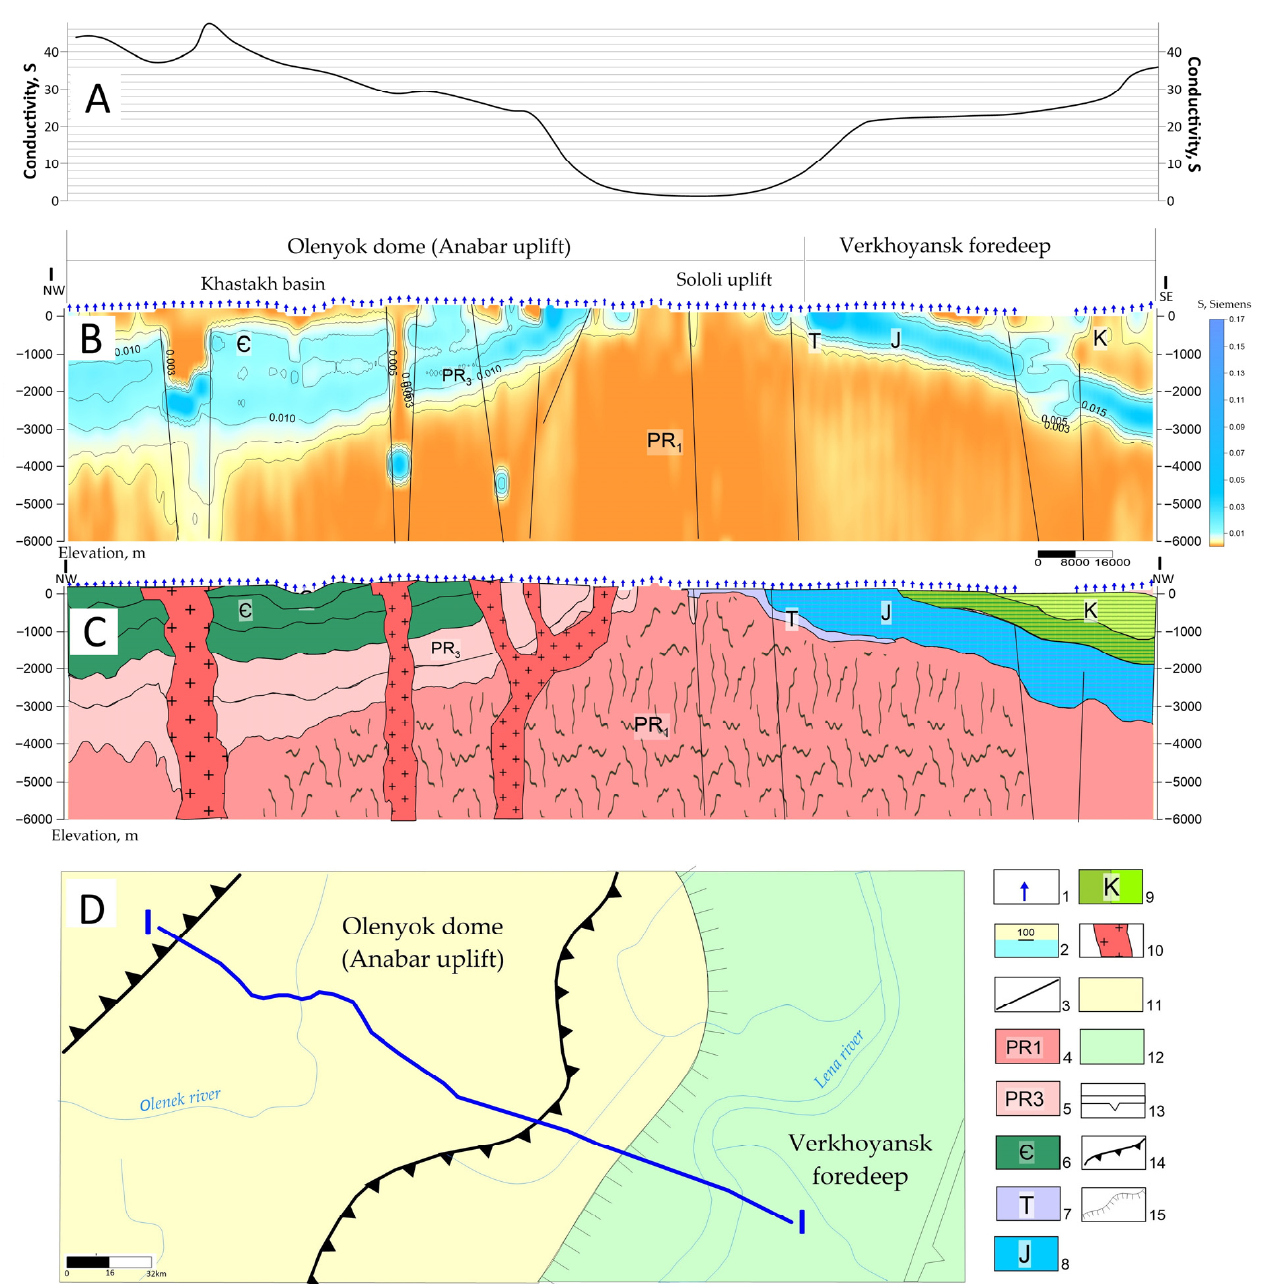
Figure 2. Total conductivity pattern from 2D TEM ( A ); differential conductivity ( B ) and geological ( C ) cross sections imaging the junction between the Olenyok Arch and the Verkhoyansk Foredeep, according to 2D TEM data; simplified local tectonics ( D ). 1 = TEM stations; 2 = resistivity layers and their resistivity in Ohm ‧ m; 3 = inferred faults; 4 = early Proterozoic metamorphic rocks; 5 = Upper Proterozoic clastic and carbonate rocks; 6 = Cambrian carbonate sediments; 7–9 = Triassic (7), Jurassic (8), and Cretaceous (9) clastic sediments; 10 = Early Proterozoic intrusions; 11 = Siberian Craton; 12 = Foredeep; 13 = Lena suture; 14 = boundary of the Olenyok dome core; 15 = boundary of basins on the Early Cretaceous base surface.